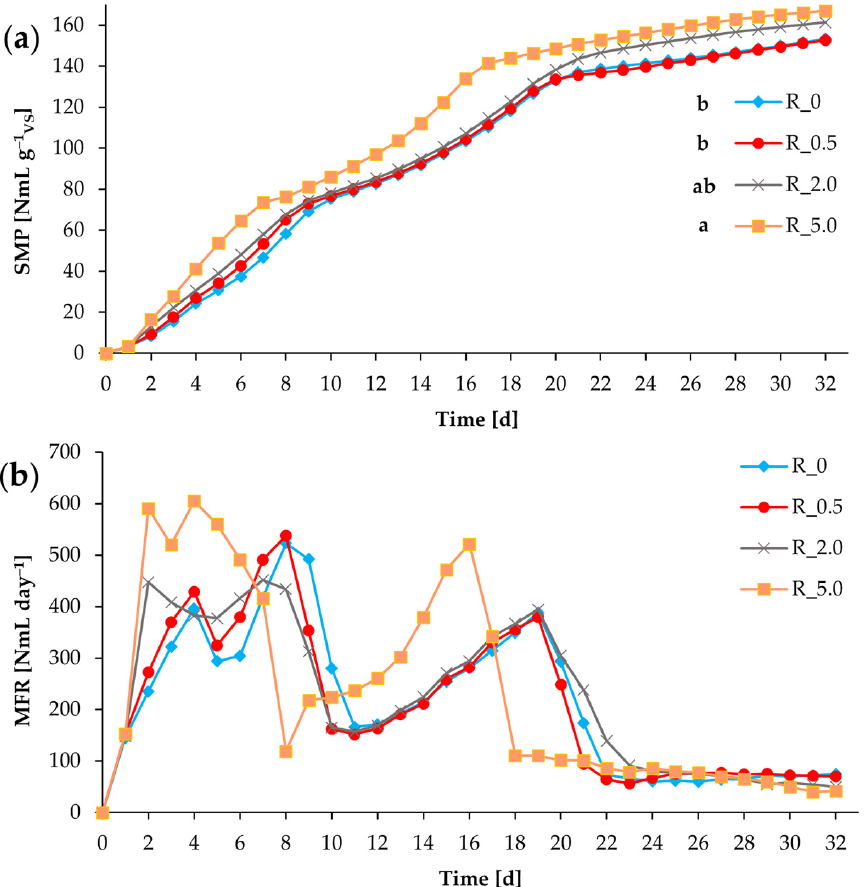
Figure 1. Impact of CNT addition on SMP ( a ) and MFR ( b ) during the anaerobic digestion of chicken manure (first batch of chicken manure). Different concentrations of CNTs (0.5 g L − 1 , 2.0 g L − 1 , and 5.0 g L − 1 ) were added to the reactors (R_0.5, R_2.0, and R_5.0, respectively). R_0 operated without the addition of CNTs. Values at day 32 (SMP) were statistically compared; a,b arithmetic means (averages) that do not share a letter are statistically significantly different from each other according to the Tukey method and 95% confidence.